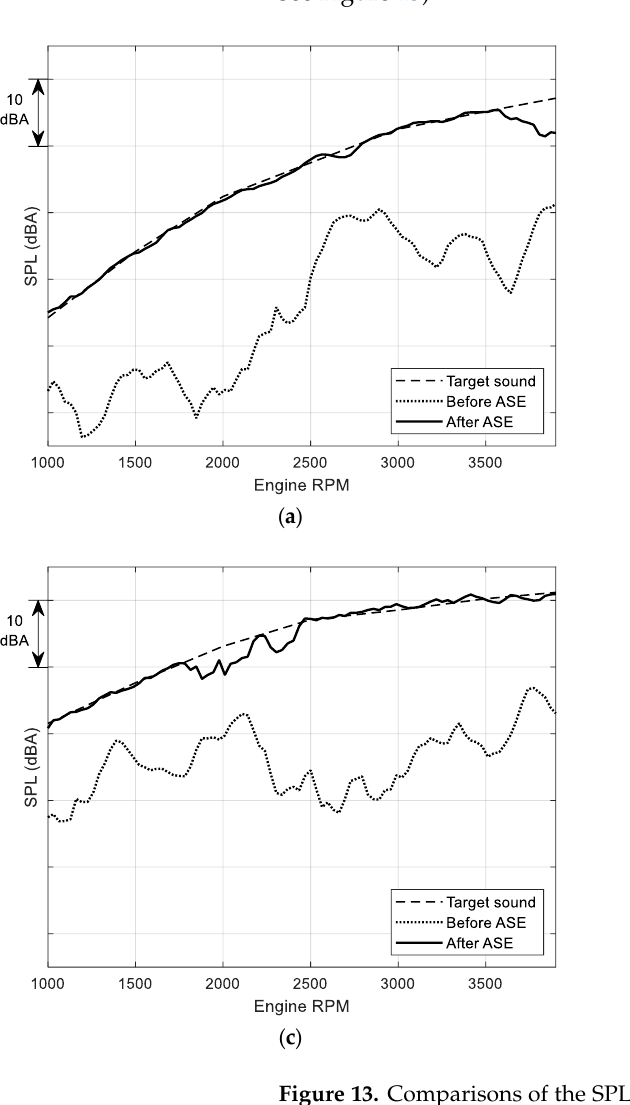
Table 1. Summary of the control performance of the proposed ASE system for the C3, C5 and C6 orders.